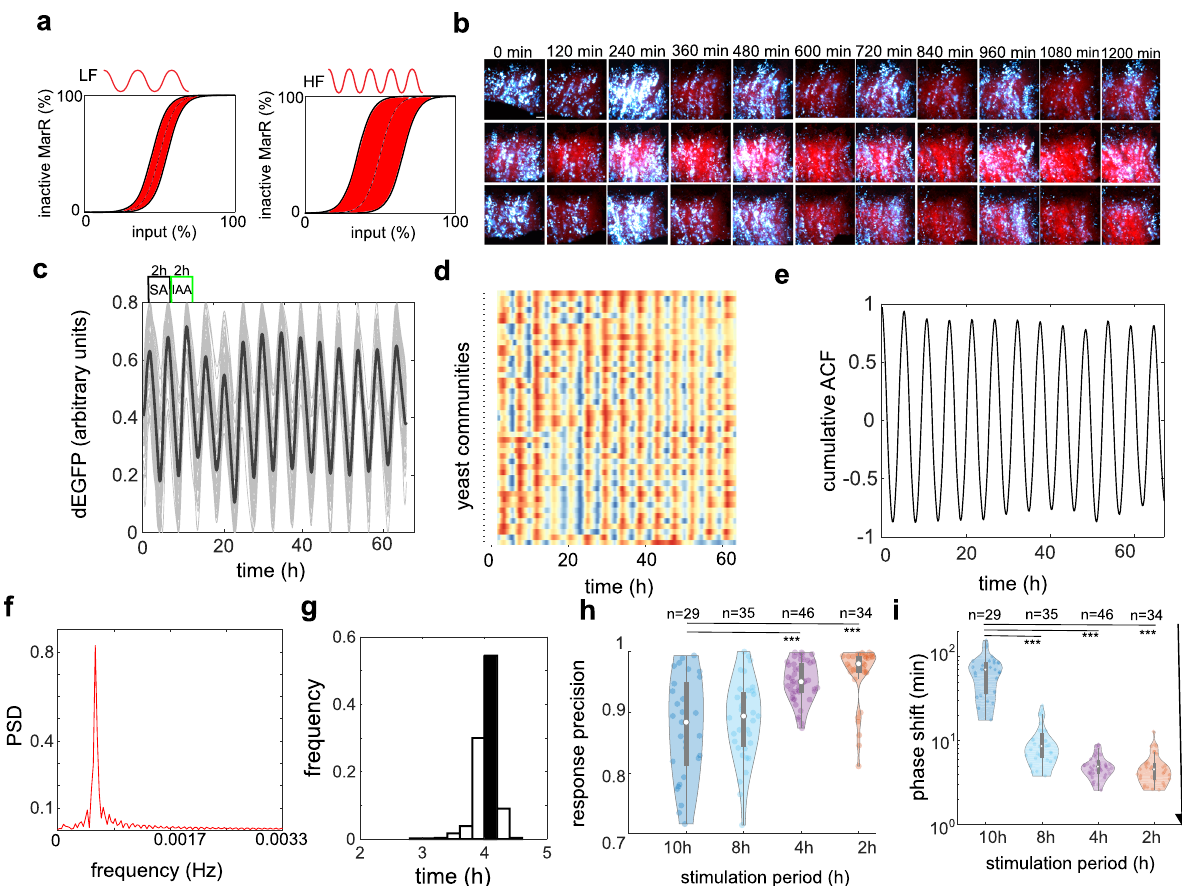
Fig. 3 Synchronous dynamics and response precision across spatially isolated yeast communities. a A theoretical model of rate-dependent hysteresis guiding SA and IAA perception dynamics. Generally, high frequency (rate) of input signal leads to an enlarged hysteresis (red region), reducing noise impact on the output switching and thus improving the synchrony. b – d Experimental validation of theory ( a ). b Example image snapshots from micro fl uidic experiments with 4 h stimulation cycles (each row represents time evolution of individual yeast community). dEGFP is shown in cyan and exponentially growing cells in red. Note a full synchrony between colonies ( c ), time evolutions of reporter fl uorescence in spatially distant yeast communities. Mean dEGFP trace for all communities is shown in black, and corresponding heat maps ( d ) for all recorded communities ( n = 46). Note, a remarkable synchrony and negligible phase drift between communities. e Cumulative autocorrelation function (ACF) calculated from all recorded communities ( n = 46) shows the robust synchronous pattern at the inter-colony level. f Power spectra density (PSD) analysis (related to e ) indicates a convergent period of response (black bar) in different yeast communities. g Probability distribution of periods for input stimulus in cycles of every 4 h ( h , i ). Violin plots of Response precision ( h ) (*** p -values = 3.2 − 7 , and 2.0 − 6 , a one-way ANOVA with post-hoc Tukey ’ s HSD), and phase drift ( i ) as a function of increasing frequency of Fig. 1i. Source data are provided in the Source Data